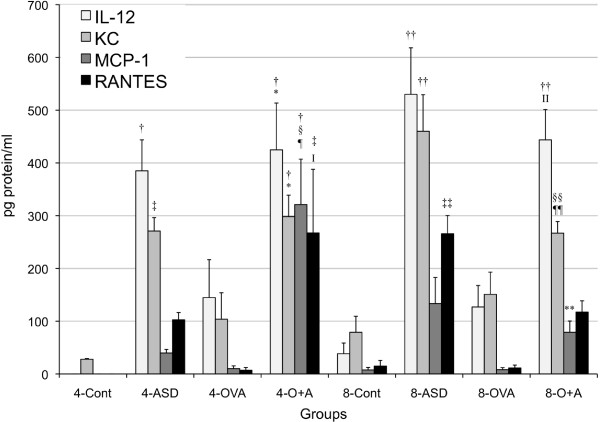
Expression of IL-12, KC, MCP-1 and RANTES in bronchoalveolar lavage fluid (BALF). All values were expressed as mean ± SE (n = 8). †p < 0.001 vs 4-Cont, ‡p < 0.01 vs 4-Cont, §p < 0.001 vs 4-ASD, ¶p < 0.001 vs 4-OVA, Ip < 0.01 vs 4-OVA, *p < 0.05 vs 4-OVA,††p < 0.001 vs 8-Cont, ‡‡p < 0.01 vs. 8-Cont, §§p < 0.05 vs 8-Cont, ¶¶p < 0.05 vs 8-ASD, IIp < 0.05 vs 8-OVA, **p < 0.001 vs 4-O+A.